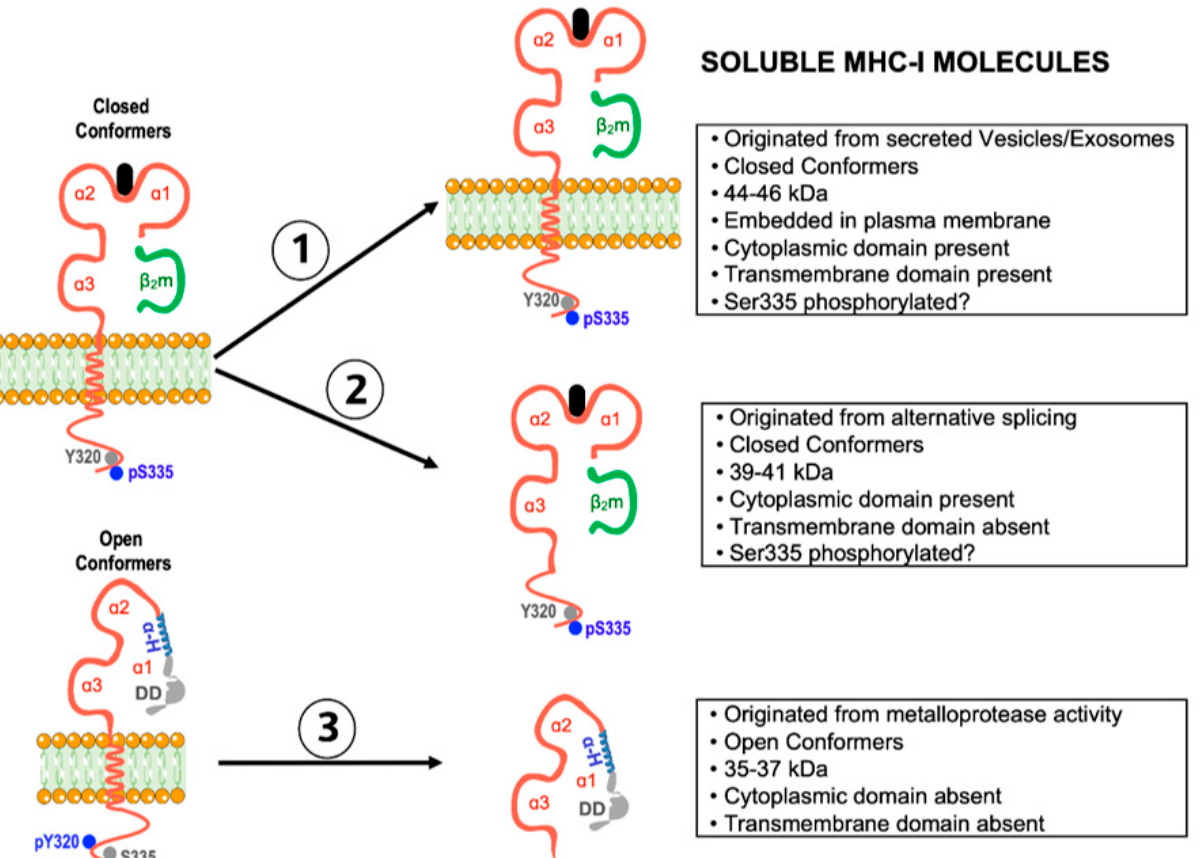
Figure 3. Schematic representation of the three main forms of soluble MHC-I molecules and their features. Soluble form 2 is not thought to be present at physiologically relevant levels in serum, leaving soluble forms 1 (closed conformers) and 3 (open conformers) as the main soluble forms (see text for more details).